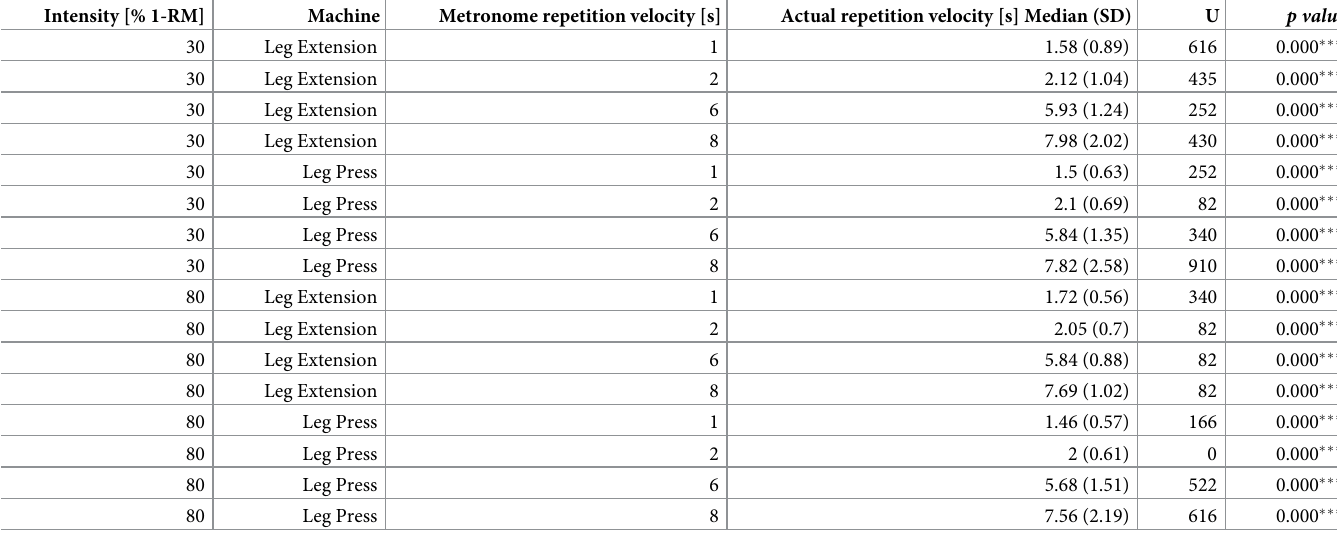
Table 3. Comparison of repetition velocities between metronome and participants. Intensity [%